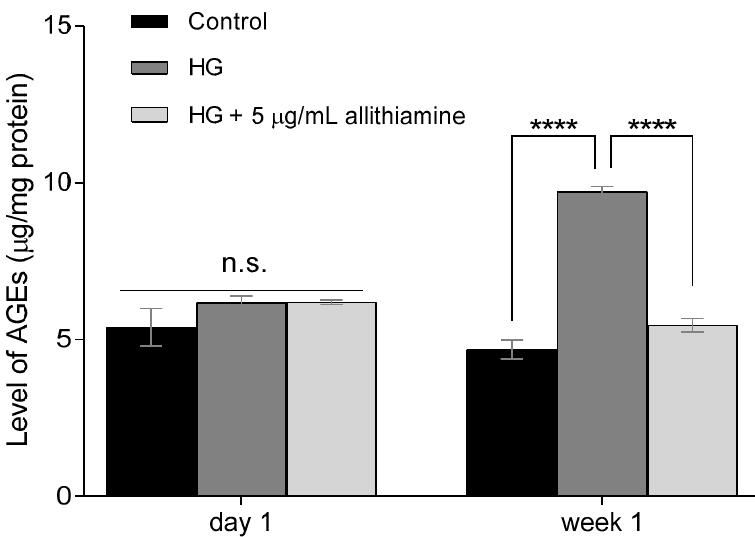
Figure 4. Effect of allithiamine on level of advanced glycation end-products (AGEs) in HUVECs after one day and one week. Data are expressed as the mean ± SEM of three individual experiments. **** marks a significant ( p < 0.0001) difference between the control and HG, and between HG and HG+5 μ g/mL allithiamine after one week. n.s.: not significant. HG: hyperglycaemia (30 mMol/L glucose).